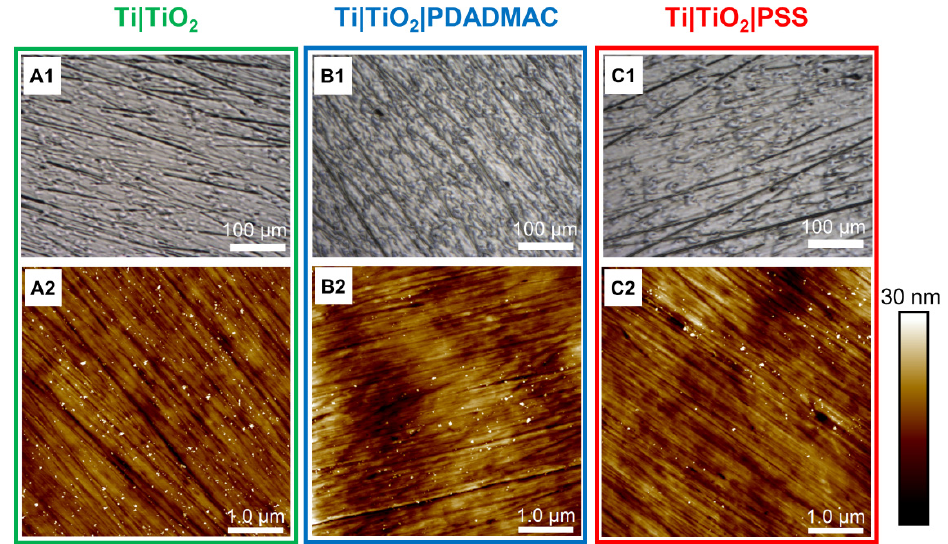
Figure 2. Images of Ti/TiO 2 surface before ( A1 , A2 ) and after adsorption of PDADMA ( B1 , B2 ) and PSS ( C1 , C2 ). The first row represents the images taken with a digital optical microscope ( A1 – C1 ) and the second row represents the images taken with an atomic force microscope ( A2 – C2 ).